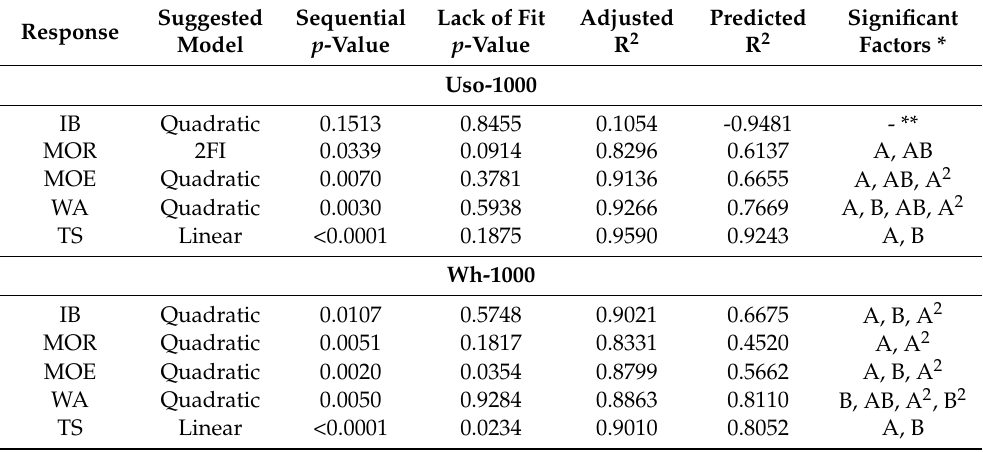
Table 3. Fit summary of suggested models for each property of the boards with the density of 1000 kg m − 3